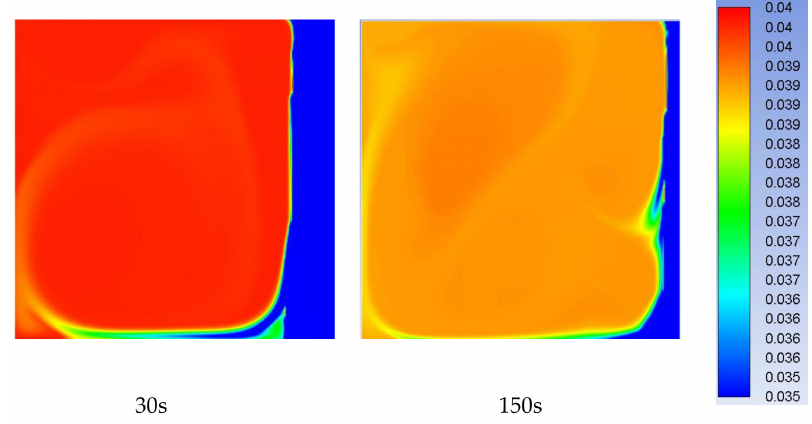
Figure 14. The carbon concentration distribution in the bath at di ff erent melting times at 1350 ◦